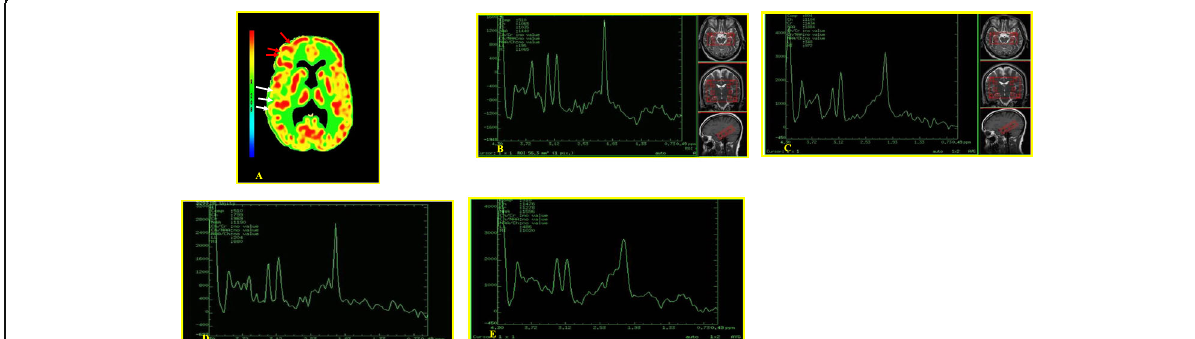
Fig. 4 a – e A 22-year-old male patient with non-lesional right temporal lobe FIAE. The visual-based analysis of the axial PASL-MRI colour-coded cerebral perfusion map ( a ) highlights the hypoperfusion of the epileptogenic right temporal lobe (white arrows) associated with focal hypoperfusion of the ipsilateral right frontal lobe, which represented the cerebral area of seizure spread (red arrows). The estimated rCBF for the right and left temporal lobes was 52.34 and 70.98 ml/100 g/min, respectively, with ASLAI% of 30.23%. Additionally, the estimated rCBF of the right and left frontal lobes was 68.92 and 75.88 ml/100 g/min, respectively, with ASLAI% of 9.61%. The MV 1H-MRS spectra of the right and left temporal lobes ( b and c , respectively), demonstrated increased MI/NAA, Glx/NAA and Glx/Cr, as well as decreased NAA/(Cho + Cr) ratios in the zone of epileptogenic activity in the right temporal lobe (b) in comparison to the contra-lateral non-epileptogenic left temporal lobe (c). For the right and left temporal lobes (b and c, respectively), these ratios were [NAA/(Cho + Cr) = 0.54 and 0.74 with %AF of 31.25%, MI/NAA = 0.74 and 0.52 with %AF of 34.92%, Glx/NAA = 1.60 and1.45 with %AF of 9.84% and Glx/Cr = 1.53 and 1.40 with %AF of 8.87%]. On the other hand, the ipsilateral right frontal lobe (d), which represented the cerebral area of seizure spread, showed decreased MI/NAA and NAA/(Cho + Cr), as well as increased Glx/NAA and Glx/Cr ratios, when compared to the contra-lateral left frontal lobe (e), where these ratios, for right and left frontal lobes, respectively, were [NAA/(Cho + Cr) = 0.67and 0.88 with %AF of 27.09%, MI/NAA = 0.57 and 0.64 with %AF of 11.57%, Glx/NAA = 1.39 and 1.30 with %AF of 6.69% and Glx/Cr = 1.34 and 1.25, with %AF of